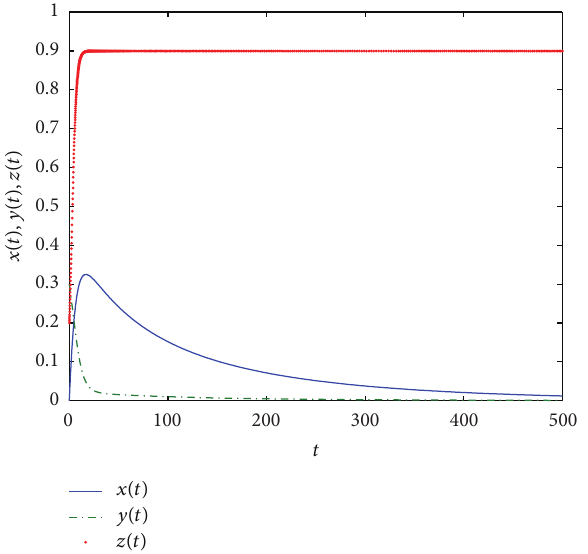
Figure 2: Parameters: 𝛽 = 0.2, 𝛼 = 0.1, 𝛾 = 0.02, 𝜇 = 0.05, 𝜔 = 0.05, 𝑐 = 0.01, and 𝛿